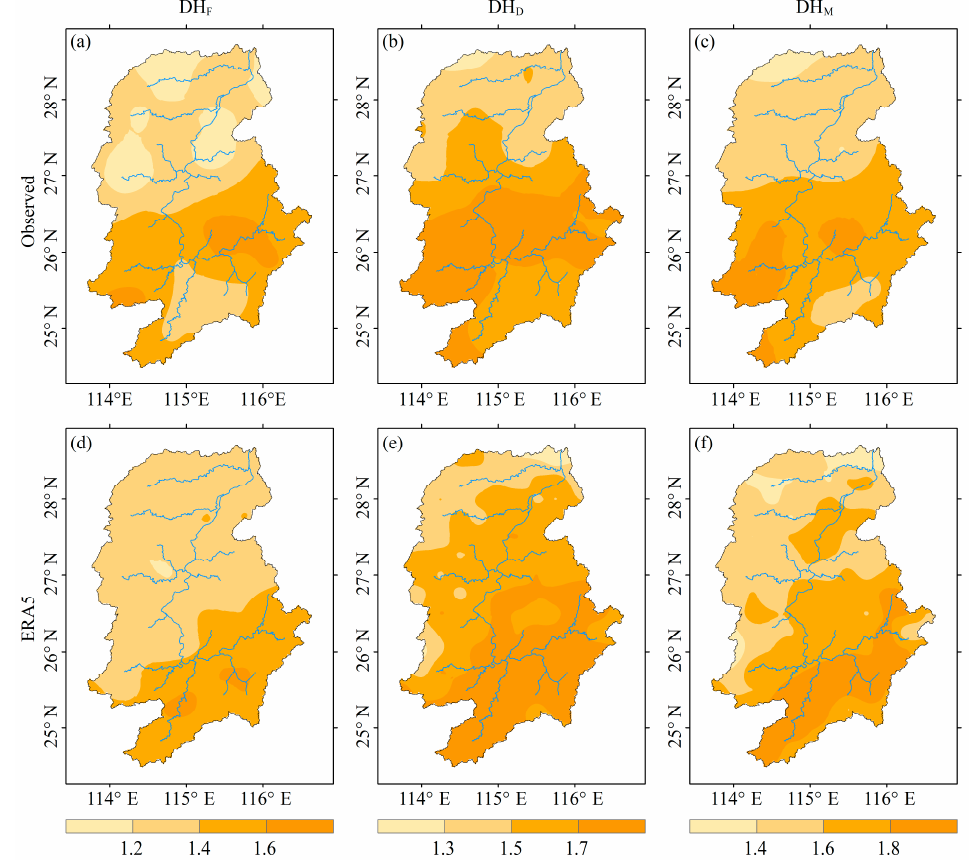
Figure 7. Spatial patterns of the D-H dependence indices for ( a , d ) DH F , ( b , e ) DH D , and ( c , f ) DH M in the observations and ERA5 during 1961–2018.